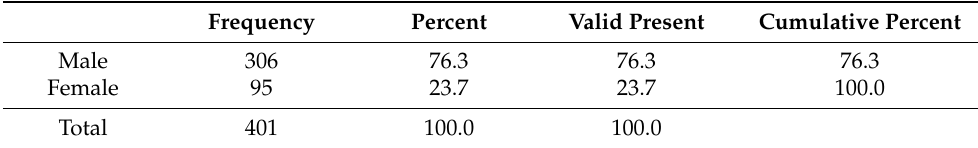
Table A1. Demographic of questionnaire participants.